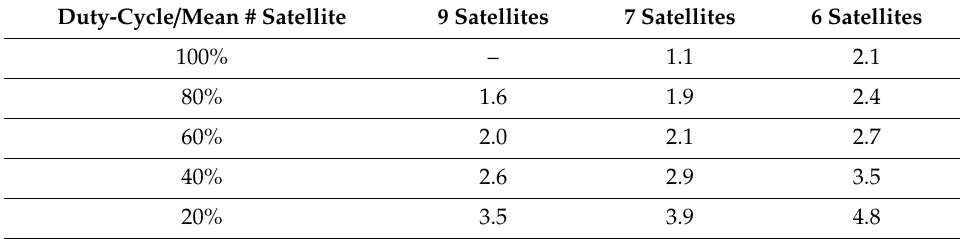
Table 3. 3D RMSE (in cm) of the phase-based reduced-dynamic orbits under different duty-cycles and mean satellite numbers.